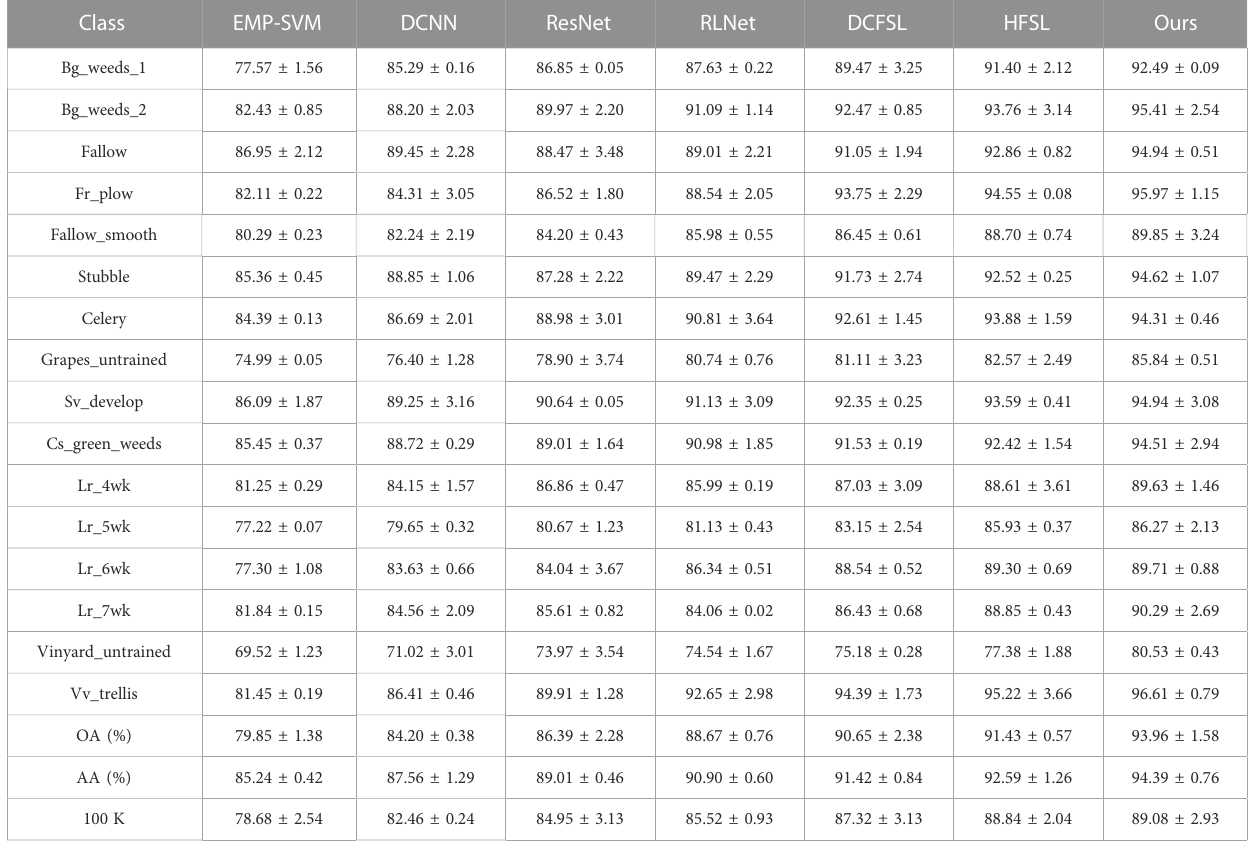
TABLE 2 Classi fi cation results of different methods on the Salinas